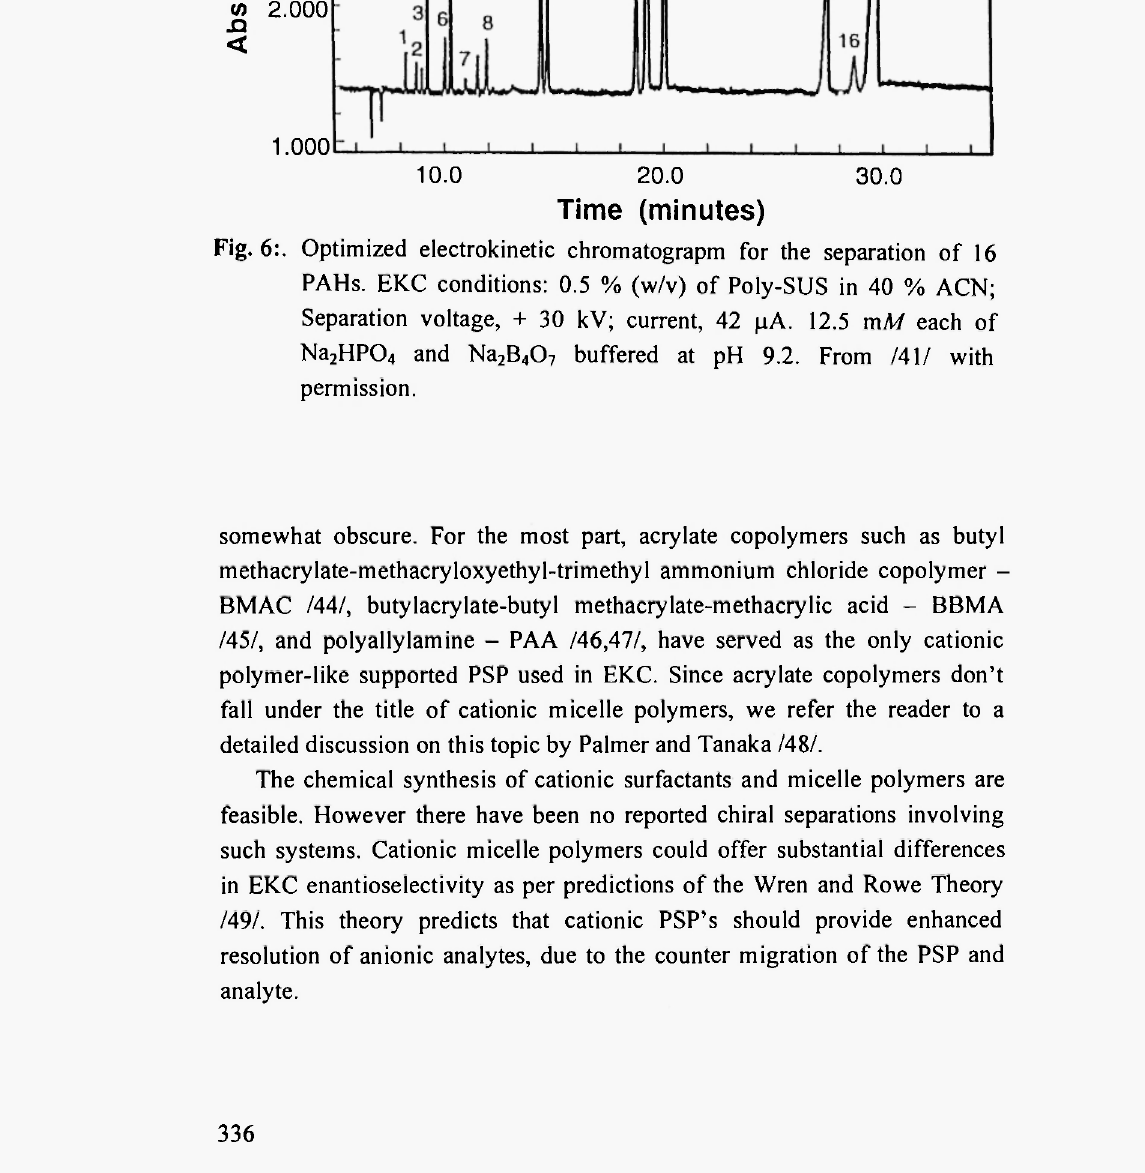
Fig. 6:. Optimized electrokinetic chromatograpm for the separation of 16 PAHs. EKC conditions: 0.5 % (w/v) of Poly-SUS in 40 % ACN; Separation voltage, + 30 kV; current, 42 μΑ. 12.5 mM each of Na 2 HP0 4 and Na 2 B 4 0 7 buffered at pH 9.2. From I AM with